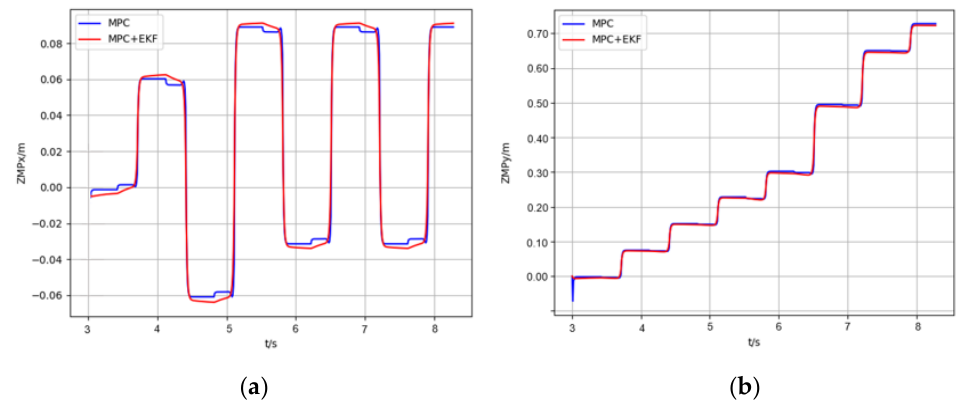
Figure 11. Real ZMP position for MPC and MPC+EKF. ( a ) The real ZMP position in the coronal plane, ( b ) The real ZMP position in the sagittal plane.